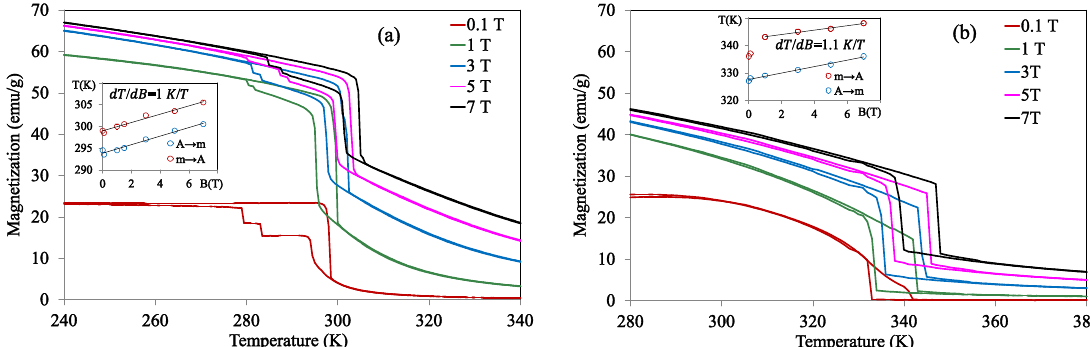
Figure 7. M ( T ) curves recorded under di ff erent magnetic fields up to 7 T for alloys x = 6 ( a ) and x = 7 ( b ); the rise of transformation temperatures with the applied field is shown in the